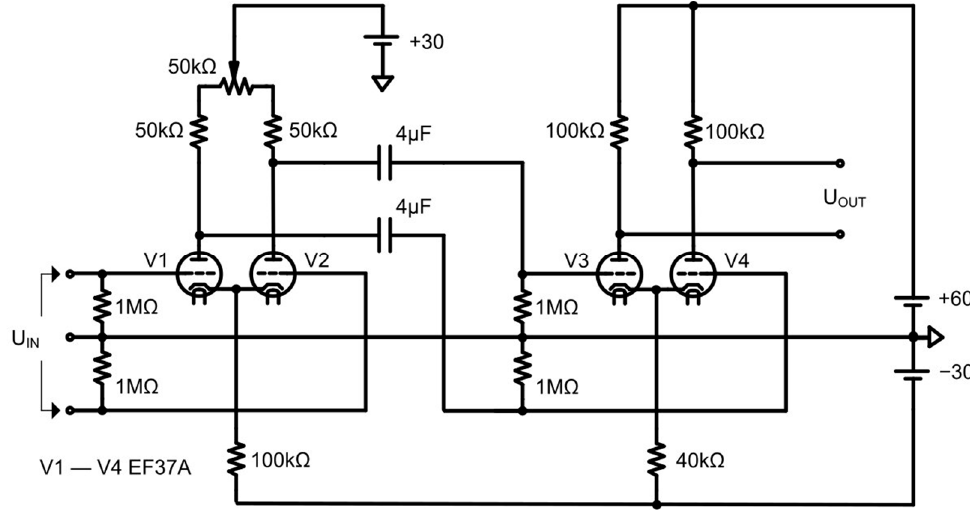
Figure 5. Differential by input and output bioamplifier on vacuum tubes